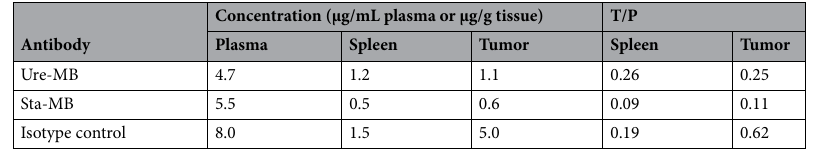
Table 1. Antibody concentrations in plasma and tissues. An Alexa Fluor 488-labeled isotype control antibody, Ure-MB or Sta-MB was administered twice at a dose of 1 mg/kg. Tissues were collected the day after the second administration. The antibody concentrations in plasma and tissue lysates were measured by electrochemiluminescence (ECL) assay.